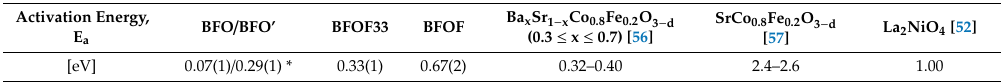
Table 2. Activation energies as calculated from the Arrhenius plots in Figure